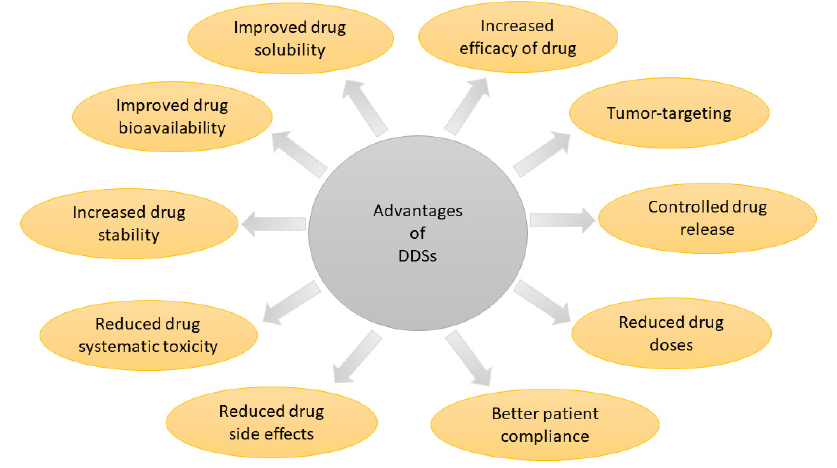
Figure 3. Advantages of drug delivery systems (DDSs).